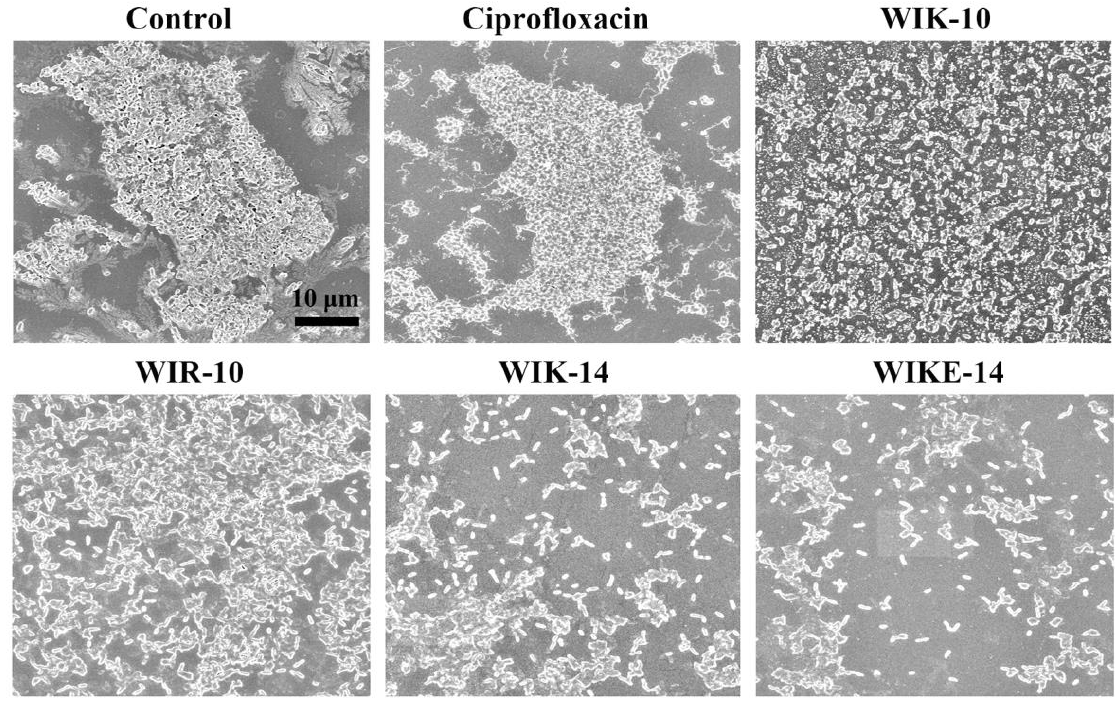
Figure 6. Image analysis of P. aeruginosa DRPa 4007 using scanning electron microscopy (SEM). The biofilm reduction on P. aeruginosa biofilms in the absence (control) or presence of ciprofloxacin (256 µM) or peptides (64 µM) was observed under SEM.